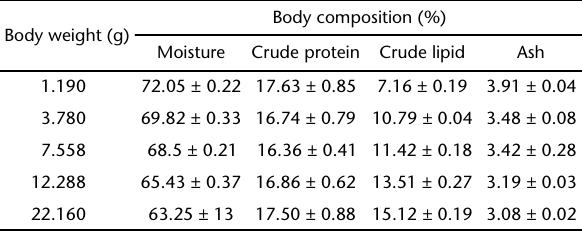
Table I. Whole-body composition (mean + SD) of Astyanax aff. fasciatus according to body weight (% wet weight basis).